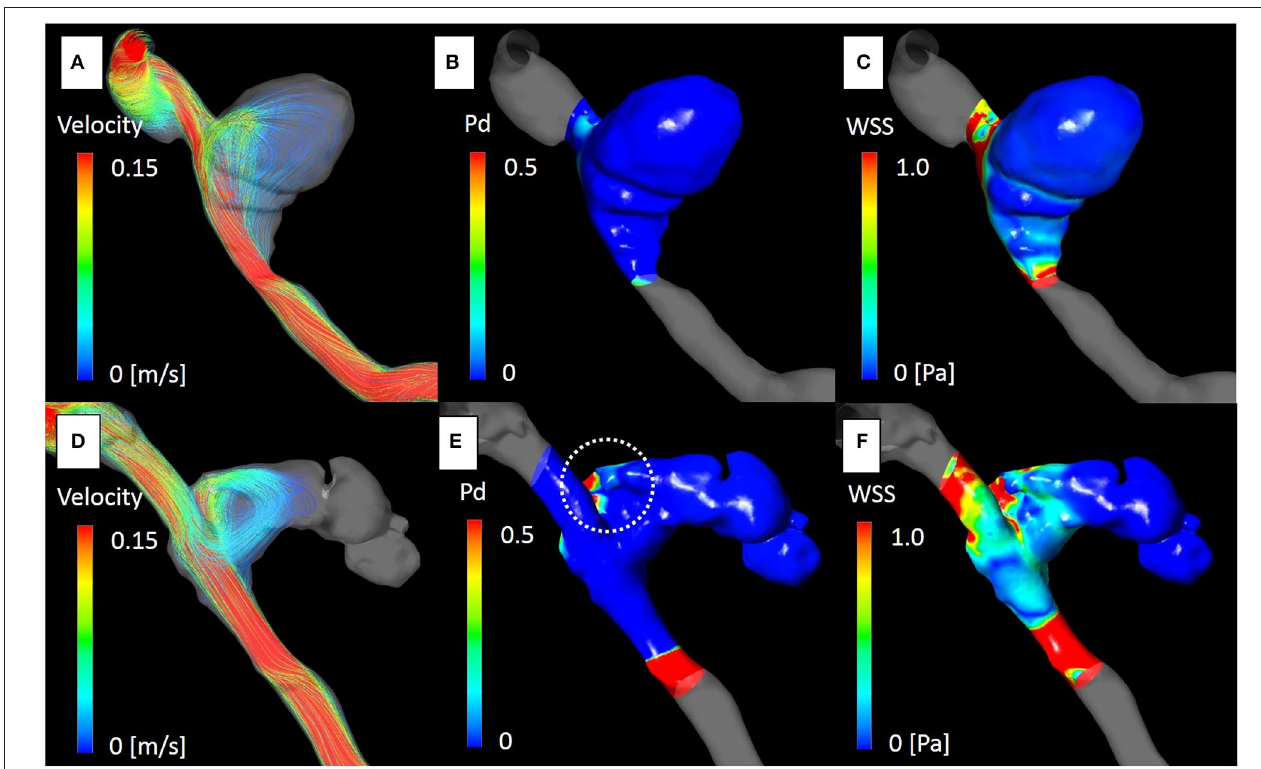
FIGURE 7 | The computational fluid dynamics study of case 4. Streamline, pressure difference (Pd) and wall shear stress (WSS) at the peak systolic phase before [ (A–C) , respectively], and after treatment [ (D–F) , respectively]. Blood flow into the aneurysm dome was altered after placement of the overlapping stents due to morphological changes in the parent artery (D) . Pd around the aneurysm neck was significantly elevated [ (E) ; white dot circle]. The maximum Pd identical to the impingement zone of the aneurysm dome was elevated from 0.08 to 1.01. WSS was generally elevated around the area (F)